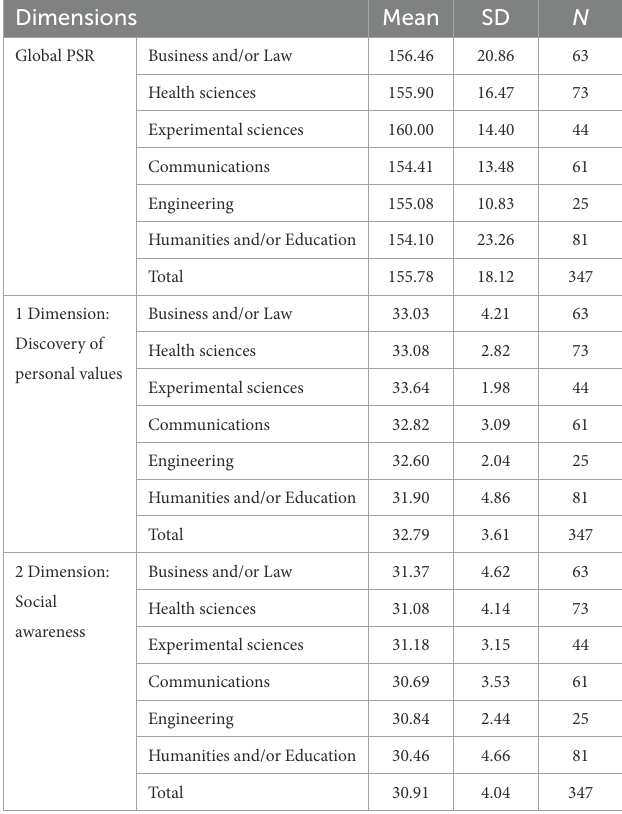
TABLE 7 Gender differences in the factorial ANOVA test gender-education. Dimensions